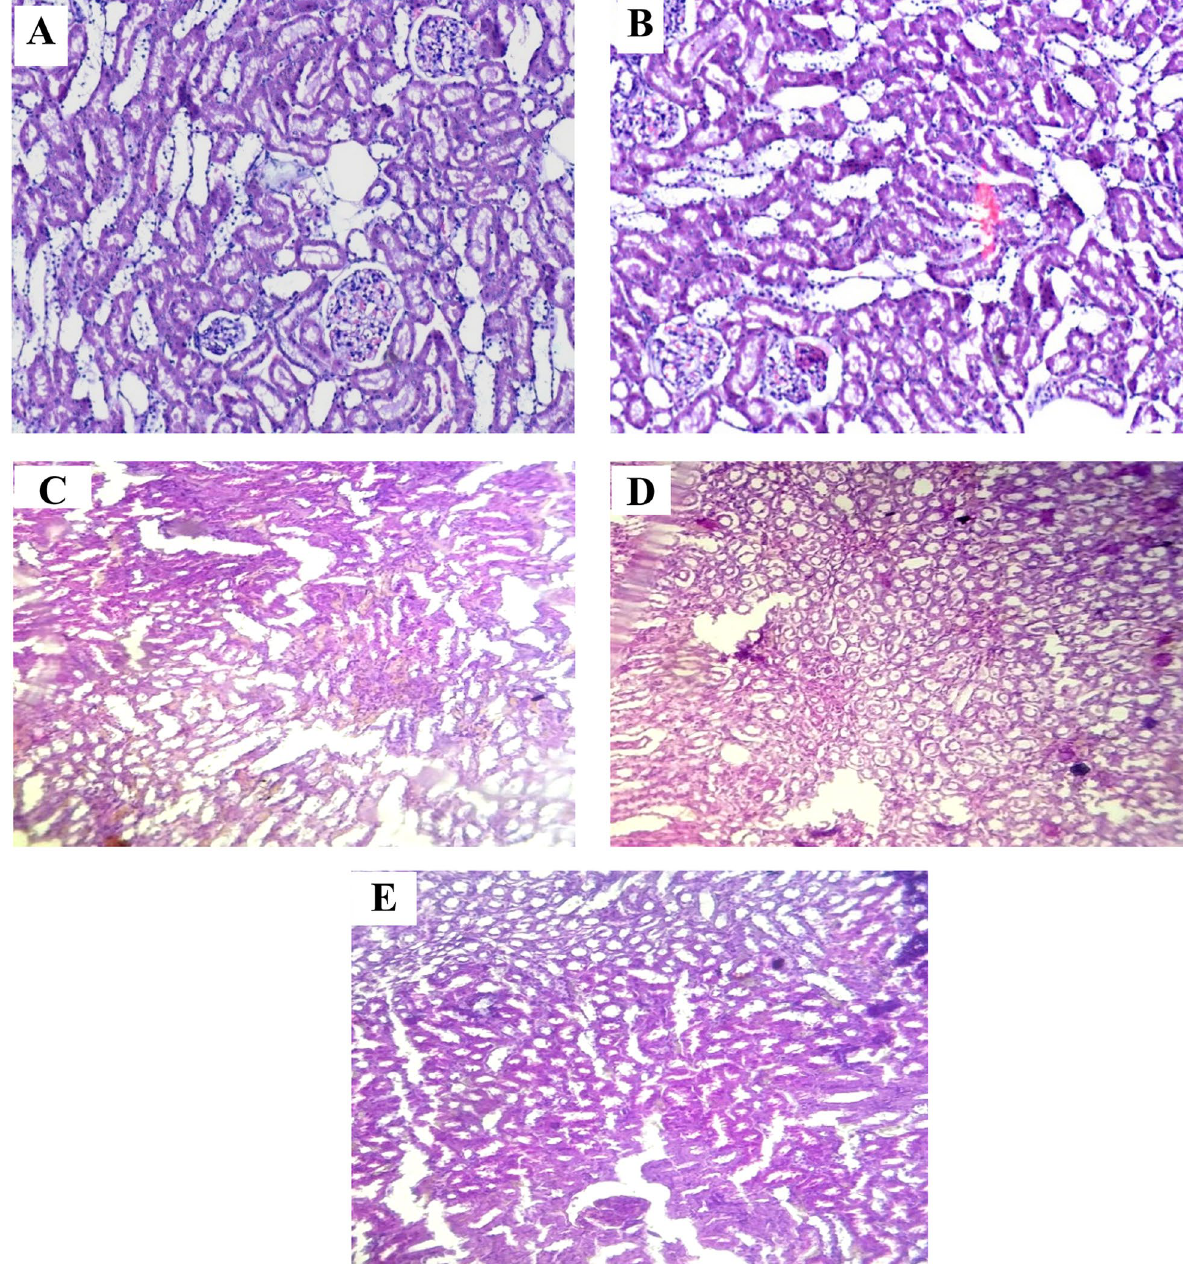
Fig. 6 Histopathologically examined the nephroprotective activity of Silymarin and Chlorzoxazone when administered along with Paracetamol (300 mg/kg). A (Control). B Represents the Kidney Histology section of rats treated with Paracetamol; pathological changes, including glomerular atrophy, degenerated tubular structure, leukocyte infiltration, and numerous tubular casts, can be seen. C , D Represents the Kidney Histology section of rats treated with paracetamol and chlorzoxazone 50 and 100 mg/kg; E Represents the Liver Histology section of rats treated with paracetamol and silymarin 100 mg/kg. The images from C – E show a significant improvement in the kidney functioning markers ( C – E ) with renal lesions, which were remarkably ameliorated by treatment with Chlorzoxazone and